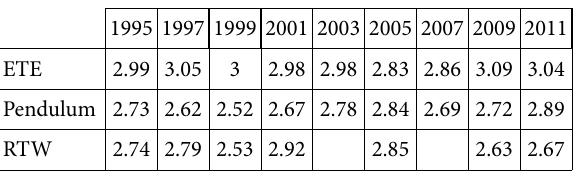
Table 7. Breakdown of average number of calls per region by route patterns